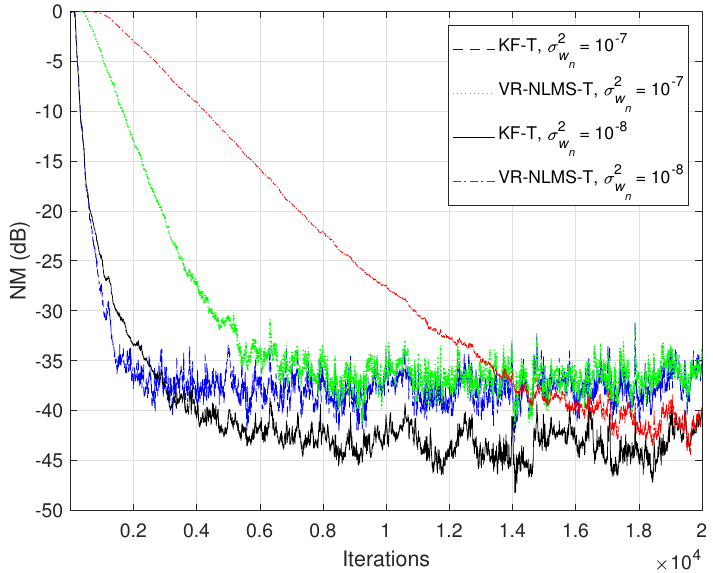
Figure 6. Normalized misalignment (NM) of the KF-T and VR-NLMS-T algorithm (using different , n = 1,2, . . . , N ), for the identification of the global impulse response, h ( t ) . values of σ 2 w n